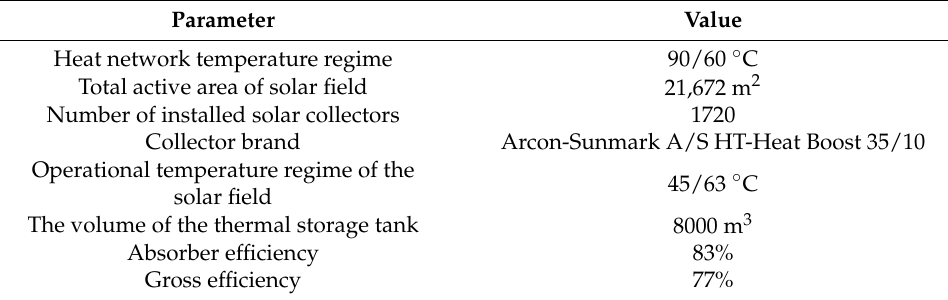
Figure 2. Case study scheme. Table 1. Overview of main solar system parameters.